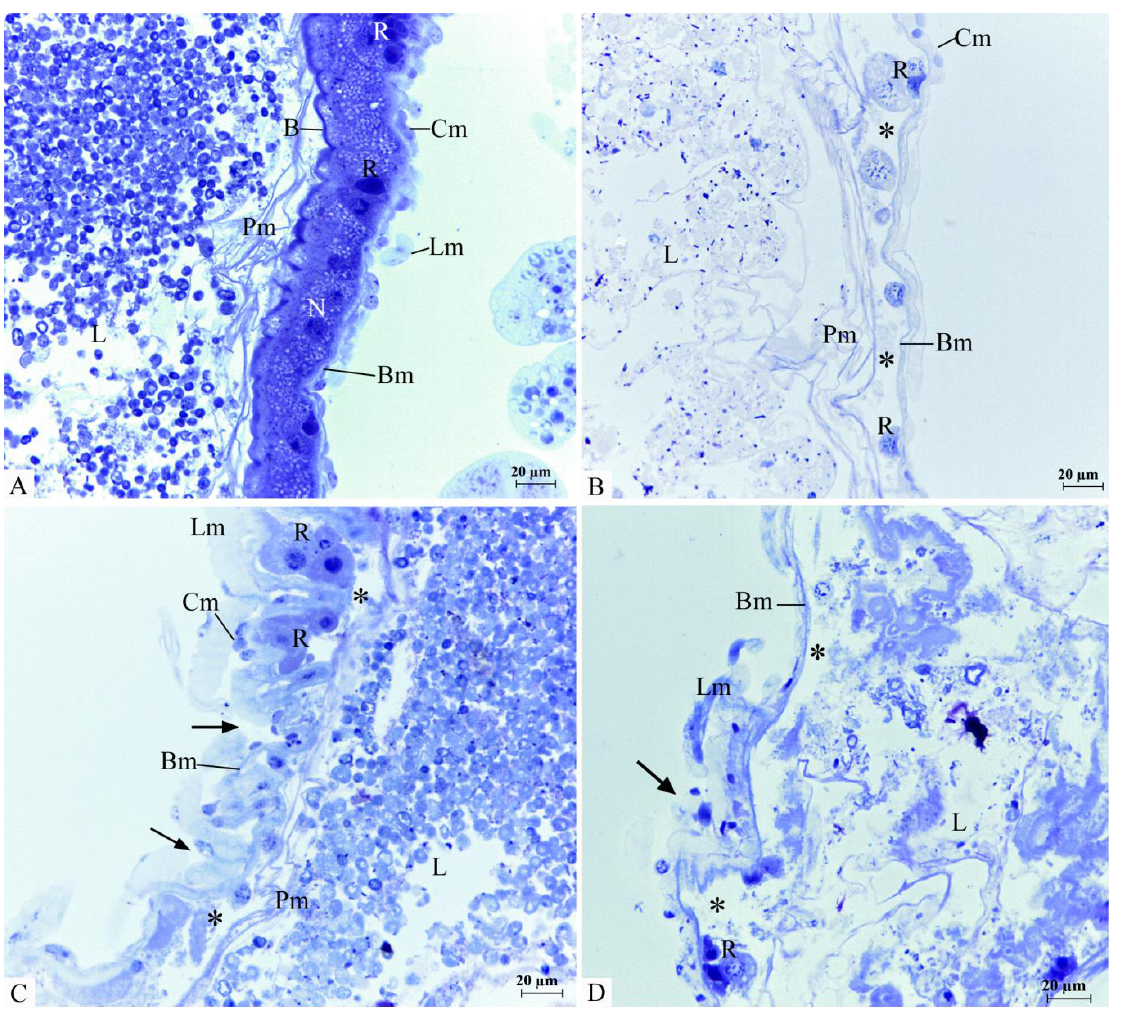
Figure 3. Morphological changes in the midgut epithelium of newly emerged adult C. claveri after treatment with C. nardus EO during the larval stage. ( A ) Control group. Epithelium is composed of columnar cells with a striated border (B) and nucleus (N) well developed and regenerative cells (R) in the basal area. These cells rest on a basement membrane (Bm) and are wrapped by circular (Cm) and longitudinal (Lm) fibers of the gut musculature. ( B – D ) C. nardus oil 1, 10, and 100 µg/mL, respectively. Note the absence of columnar cells (*) and the formation of epithelial folds ( arrows ). Perithrophic membrane (Pm); lumen (L).